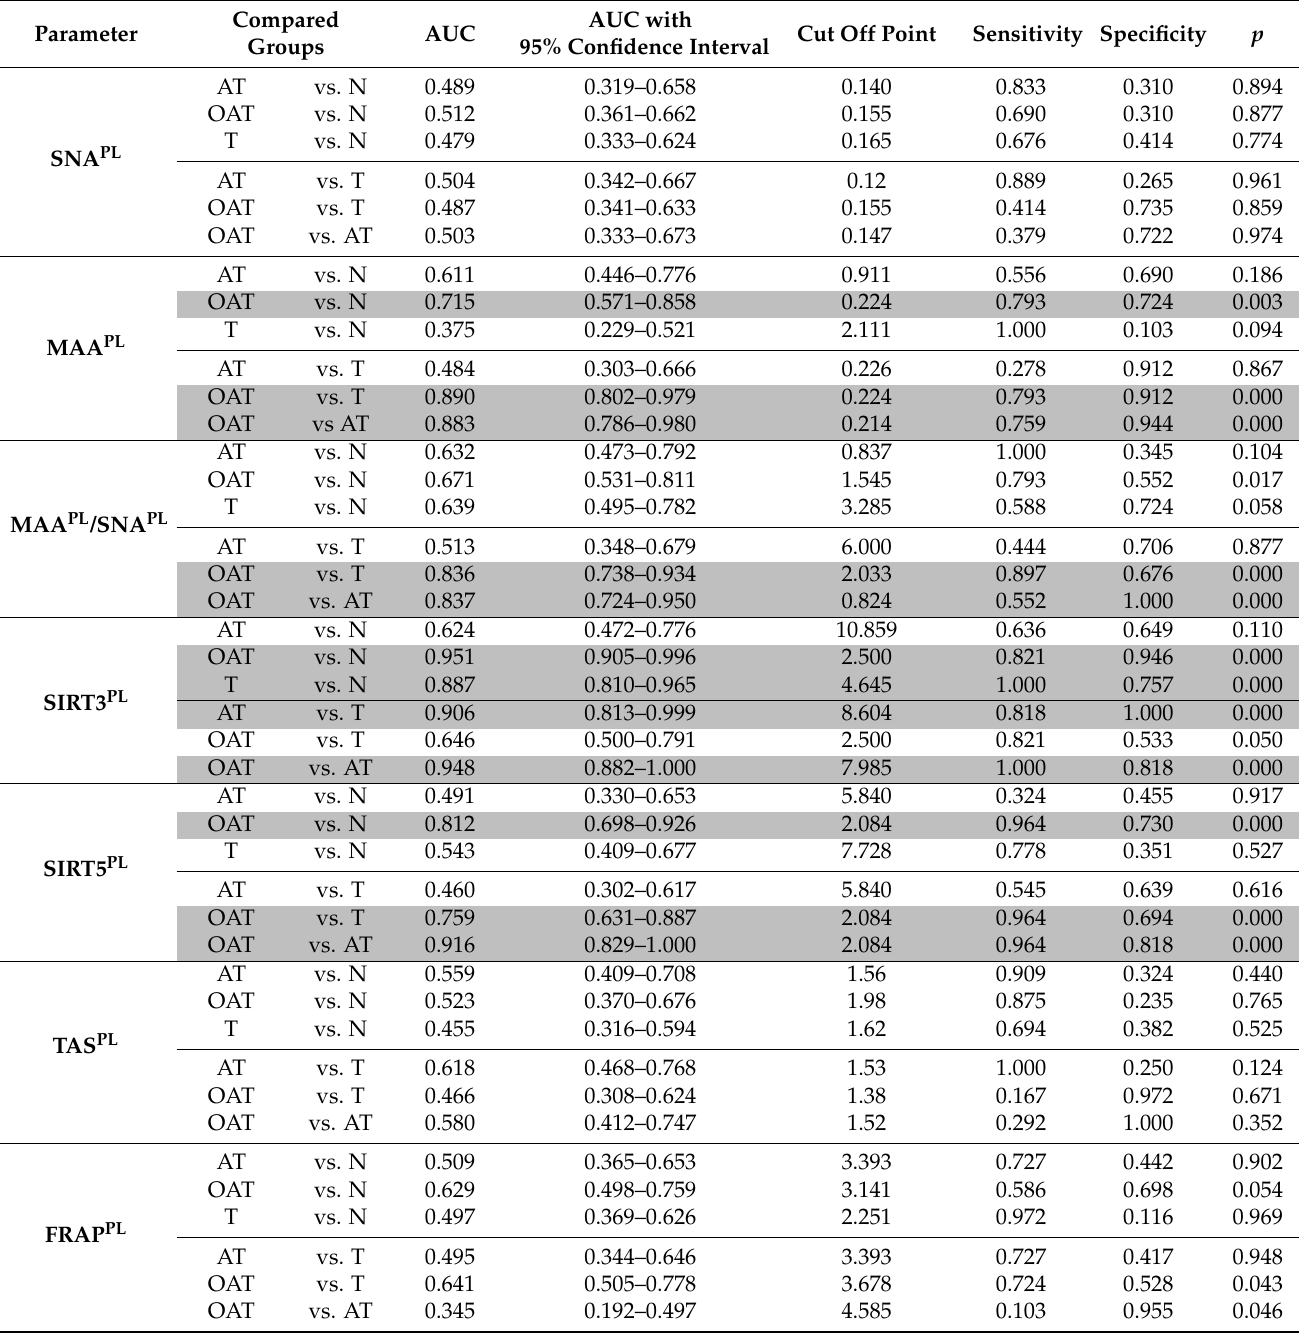
Table 2. Summary of the results of receiver operating characteristic (ROC) curves analysis for seminal plasma